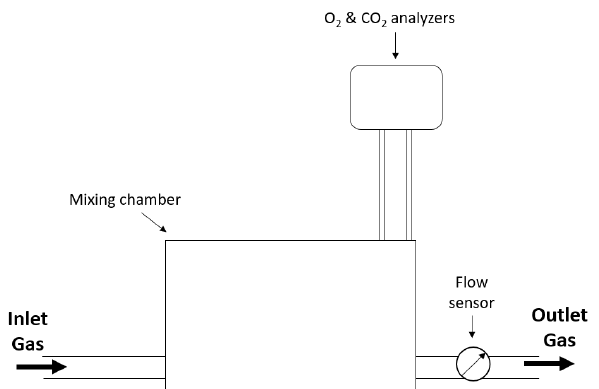
Figure 2. Generic open-circuit indirect calorimeter using the mixing chamber technique with the bold arrows indicating the direction of gas